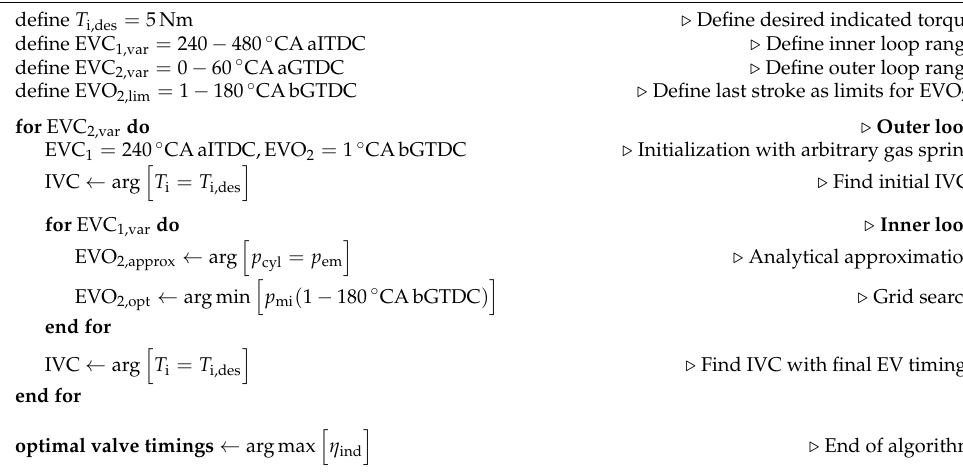
Algorithm 1 Search for Valve Timings Maximizing the